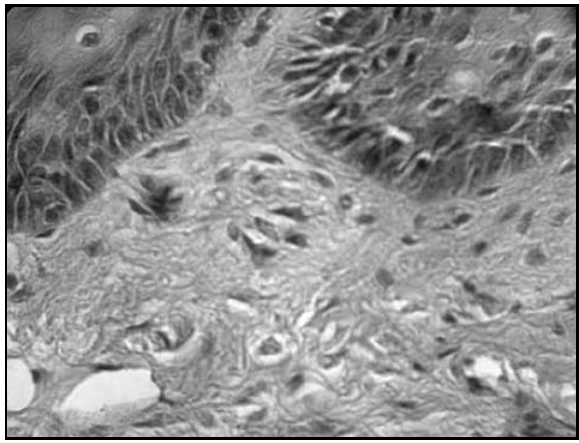
Figura 4 – Aspecto microscópico (HE, 10x)